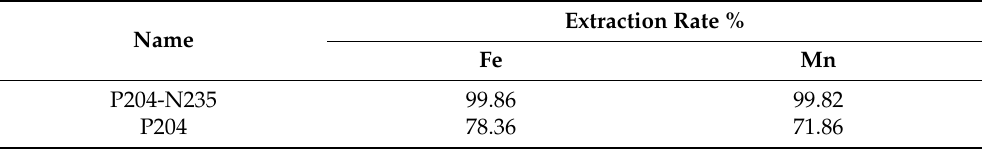
Table 3. Comparison of the effects of P204-N235 and P204 on Fe and Mn extraction.